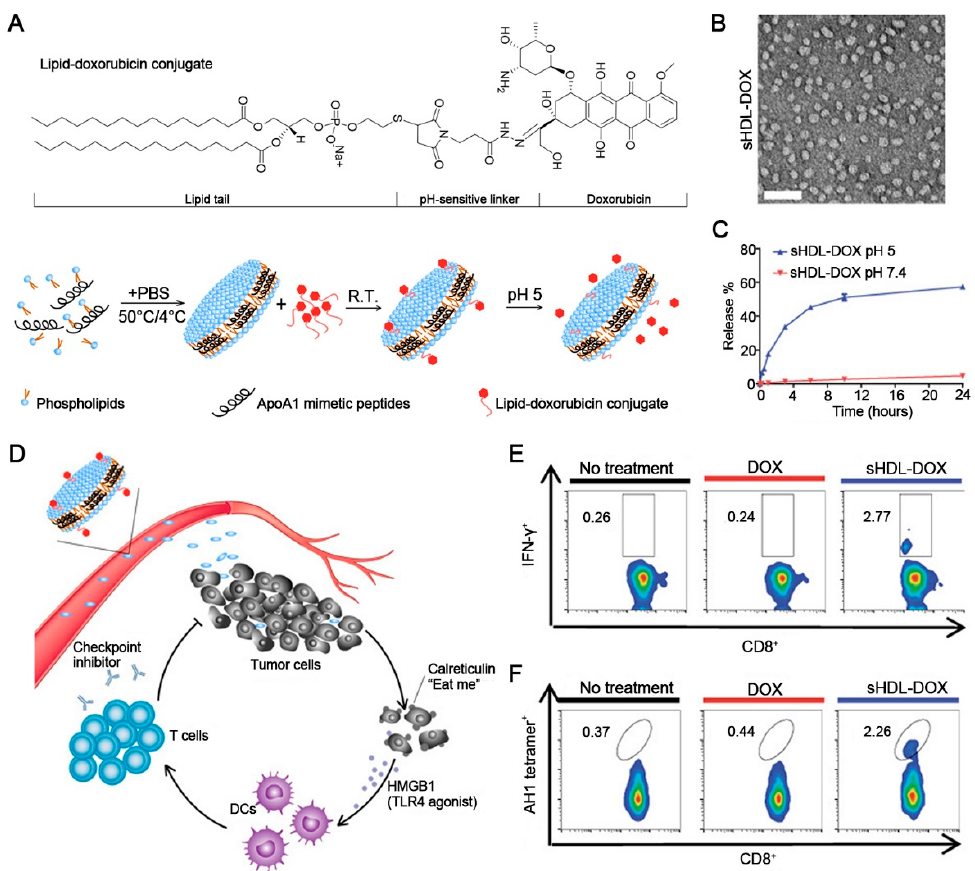
Figure 4. Schematic of sHDL-Dox for chemo-immunotherapy. ( A ) Schematic of the lipid-DOX conjugate and the preparation process. ( B ) The image of sHDL-DOX using a transmission electron microscope. Scale bars, 50 nm. ( C ) The release of DOX at pH 5 and pH 7.5. Data represent mean ± SD ( n = 3). ( D ) Schematic of sHDL-DOX triggering antigen release for cancer immunotherapy. ( E ) The increased percentage of IFN- γ + CD8+ T cells induced by sHDL-DOX. ( F ) The increased percentage of CT26 tumor antigen peptide AH1-specific CD8+ T cells induced by sHDL-DOX. Reprinted with permission from Ref. [123]. Copyright 2018, copyright the American Association for the Advancement of Science.